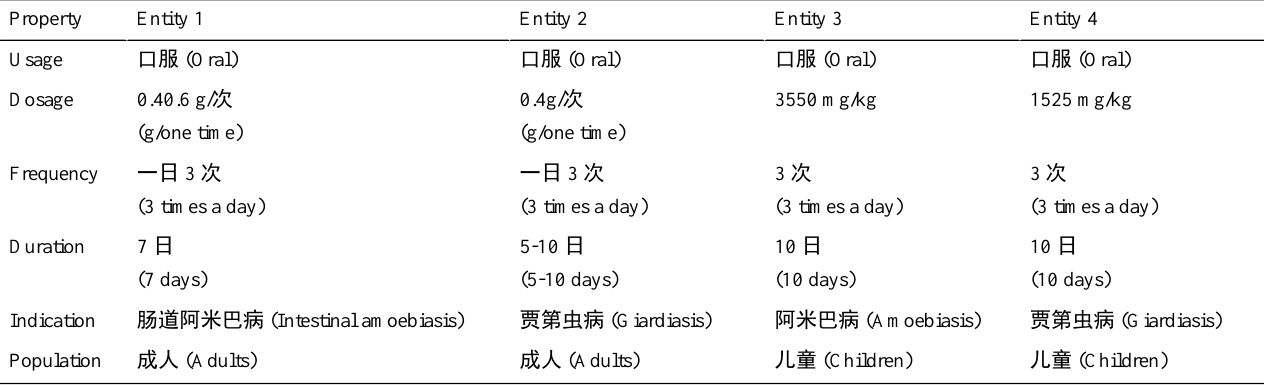
Table 1. Property values extracted from the usage section in the instructions of metronidazole tablets.